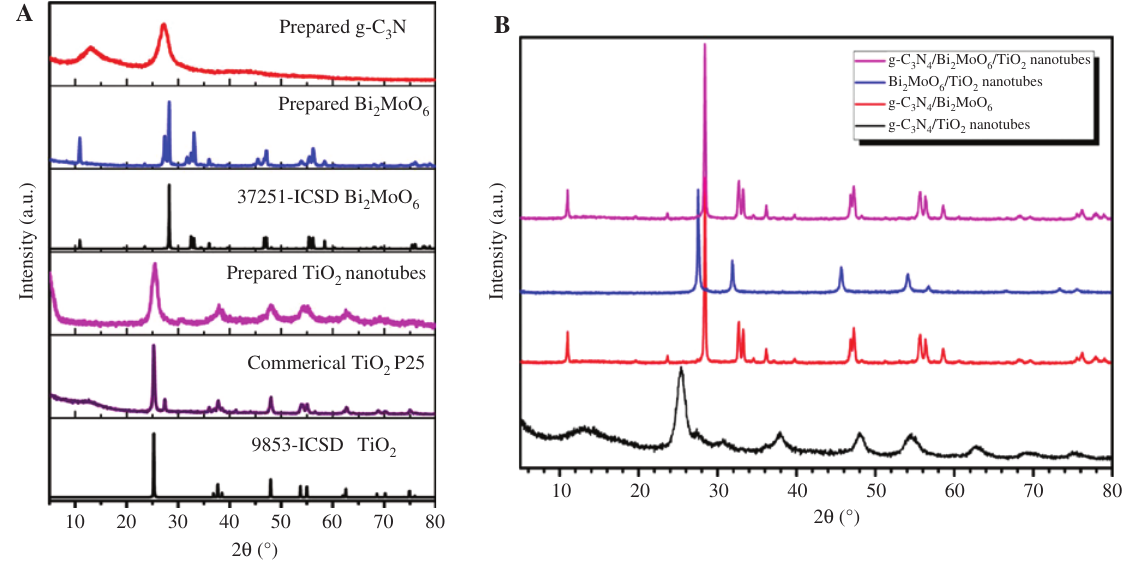
N , Bi MoO , and TiO nanotube and (B) binary and ternary composite 3 4 2 6 2